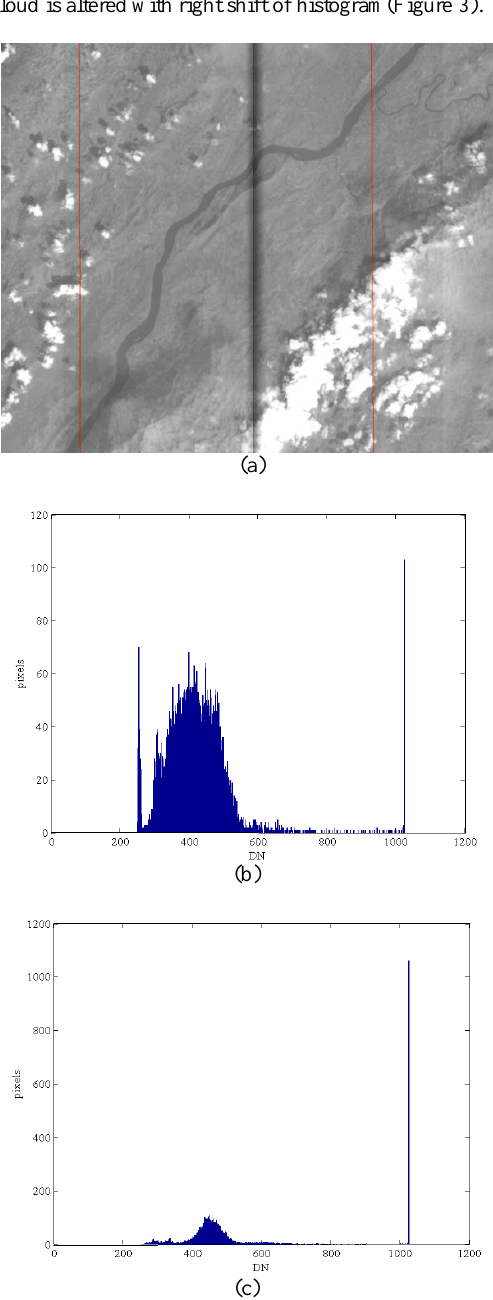
Figure 3 (a) 0-level panchromatic images of SJ-9A satellite(2014-10-14,Laos),(b)histogram of pixel 2000,(c) histogram of pixel 7000 The image filtering based on cloud detection is:classification